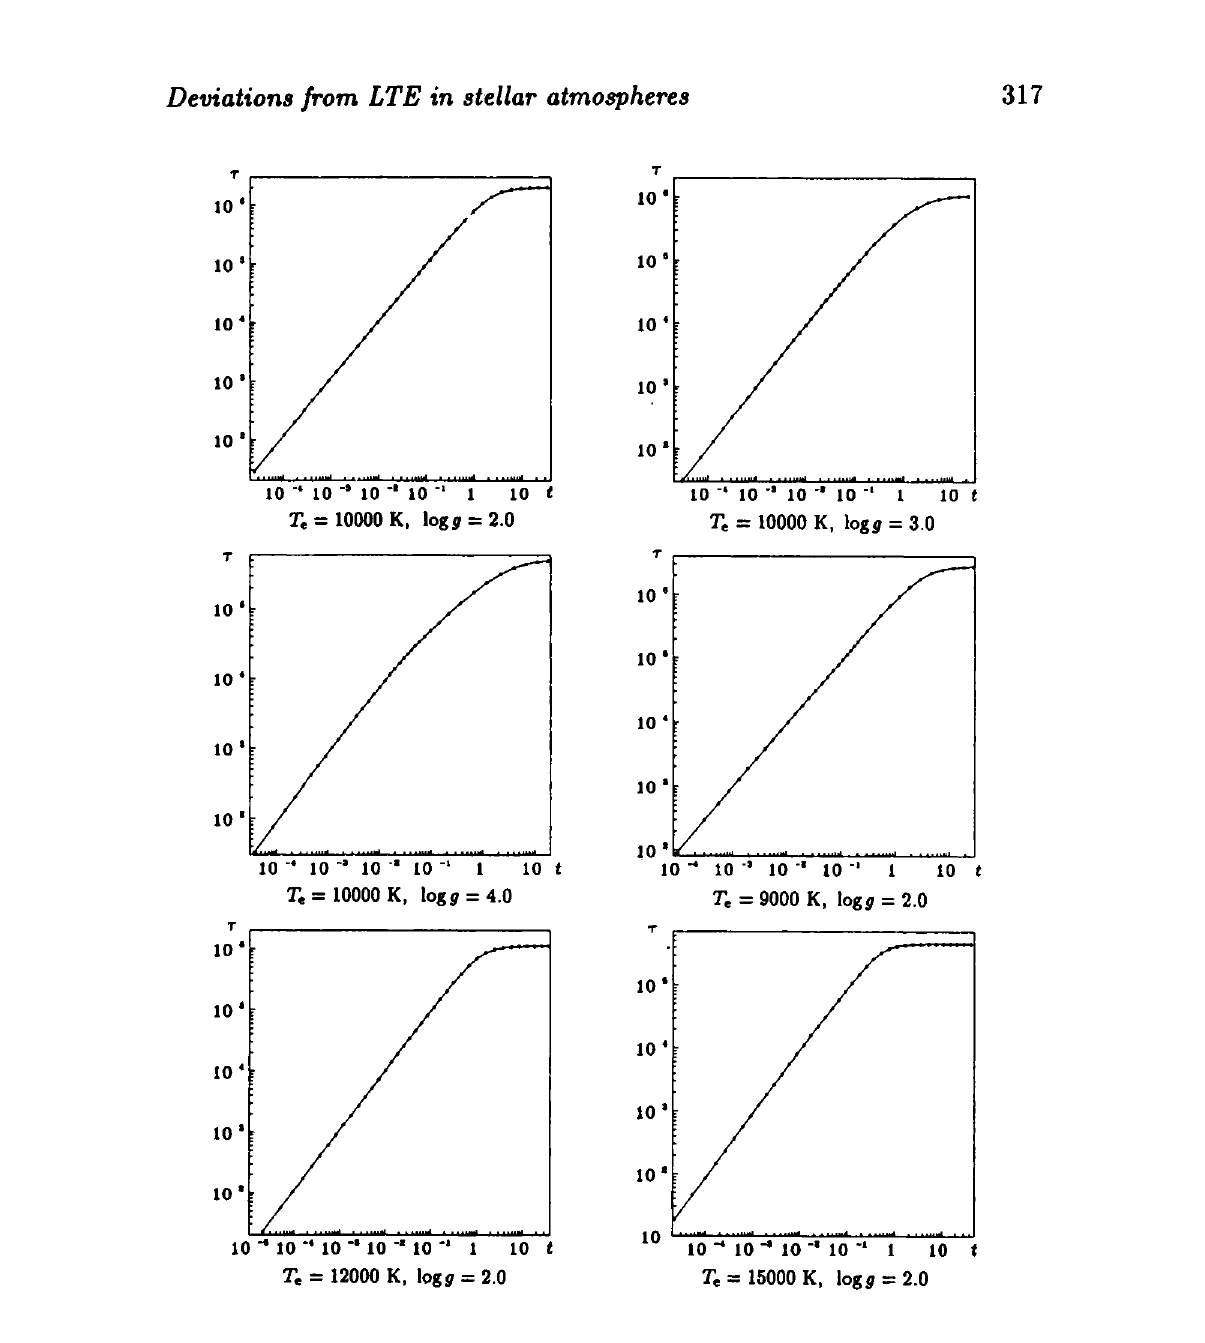
Fig. lb. The run of the optical depth r in the line center for the esonance spectral line CII λ =1334.515 Ä for different model atmospheres vith effective temperature Τ and gravity g. The argument is logarithm of optical depth t in the continuous spectrum at the spectral line